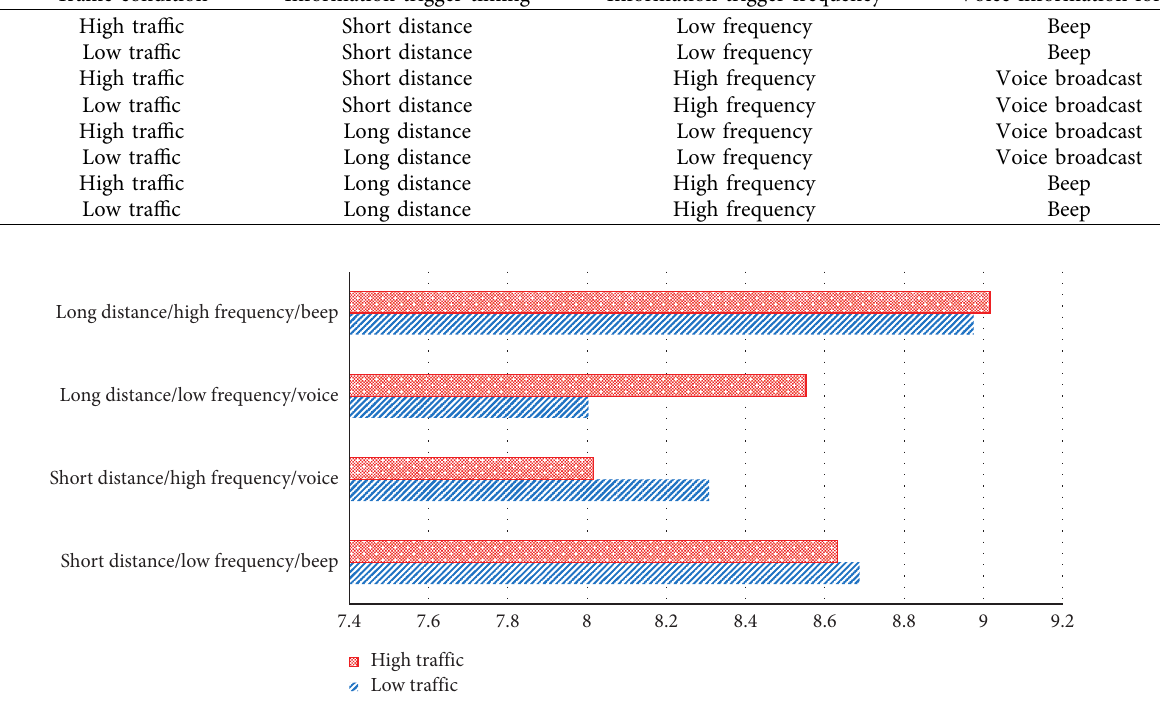
Figure 4: Subjective mental load at high and low traffic